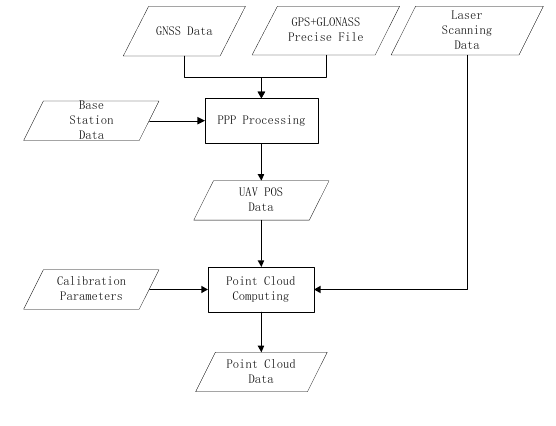
Figure 2. Point cloud post-processing